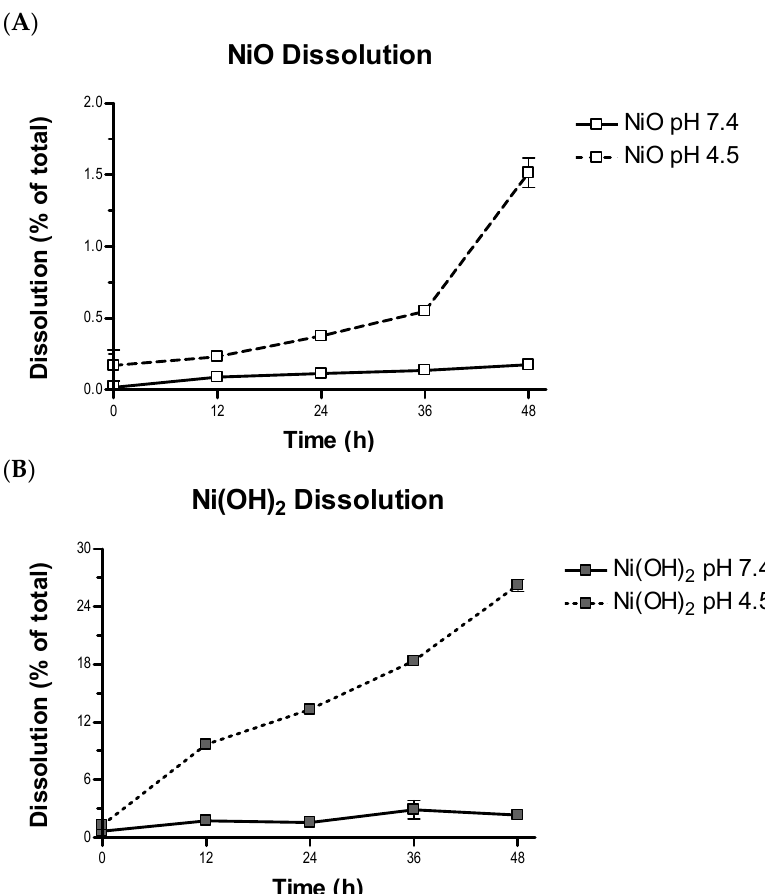
Figure 3. Dissolution of ( A ) NiO and ( B ) Ni(OH) 2 at 7.4 and 4.5 pH after 12, 24, 36, and 48 h. Ni in solution was analyzed using inductively coupled plasma-optical emission spectrometry (ICP-OES) and compared to the initial mass of Ni in constant composition experiments. Values are expressed as the mean ± SD from three measurements.